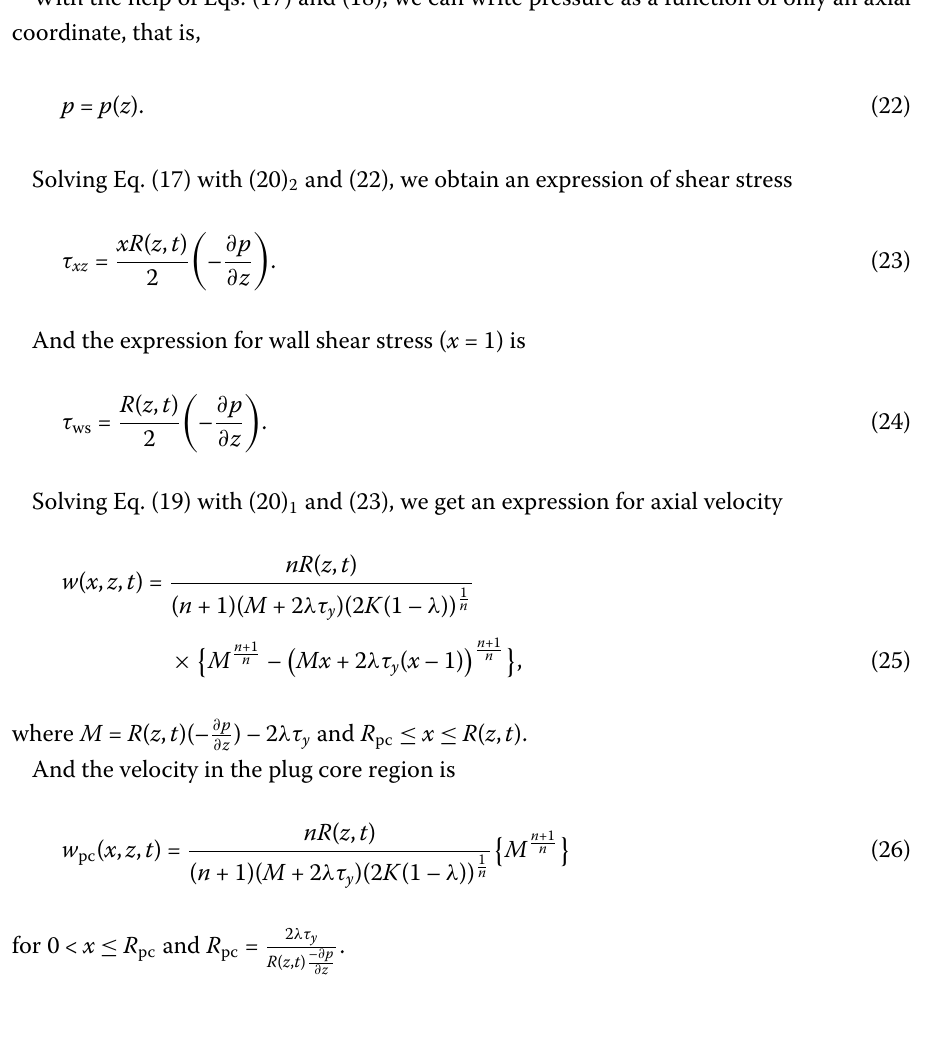
where R pc is the radius of plug core